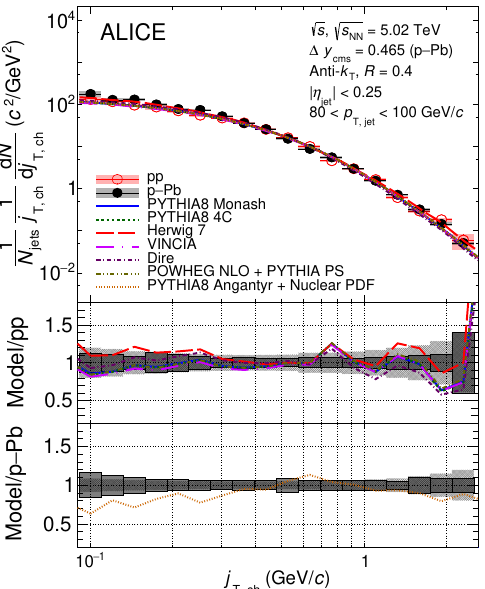
√ √ s, s NN = 5 . 02 TeV for 80 < p T , jet <